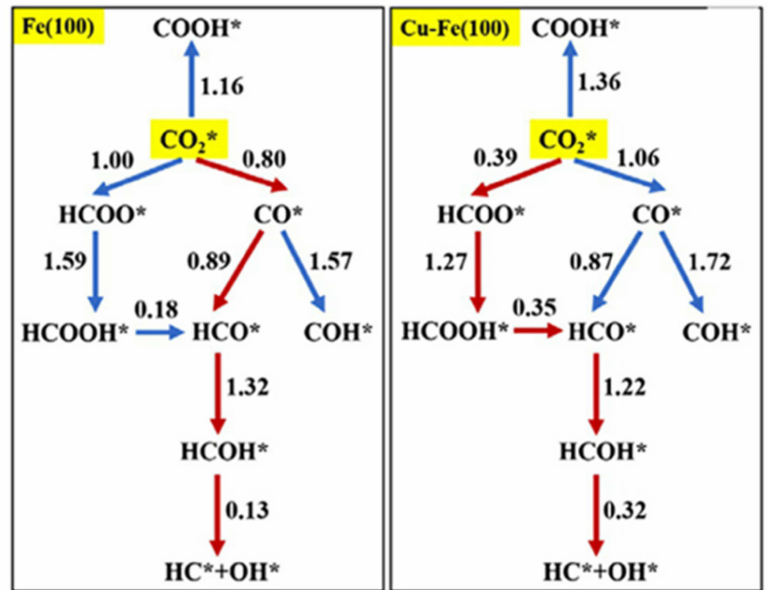
Figure 20. Reaction networks examined to identify energetically favorable C 1 species from CO 2 hydrogenation on the Fe (100) and Cu-Fe (100) surface. Activation barriers are given in eV (the networks connected with red arrows represent the preferred path for CO 2 conversion to CH*). Reprinted with permission from Nie et al. [157]. Copyright (2017) American Chemical